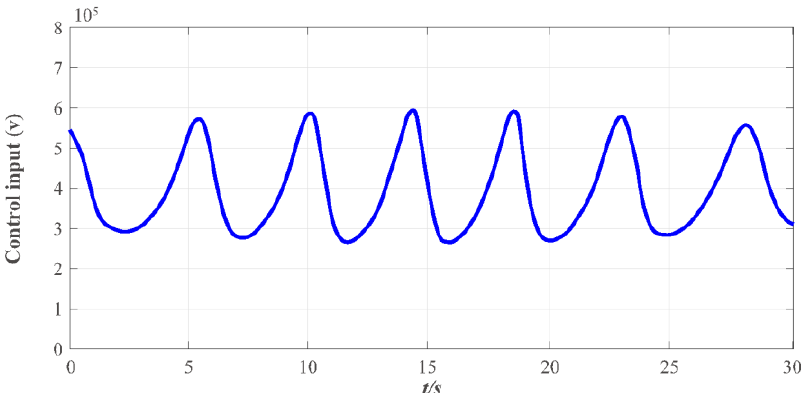
Figure 11. The control input curve under the designed FT-NITSM resonant frequency tracking con- troller.